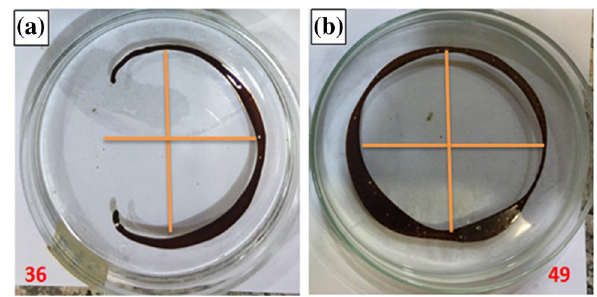
Fig. 4 Hemolytic activity of different strains: a Enterobacter aero- genes strain B19 and b Bacillus cereus strain ISU-02